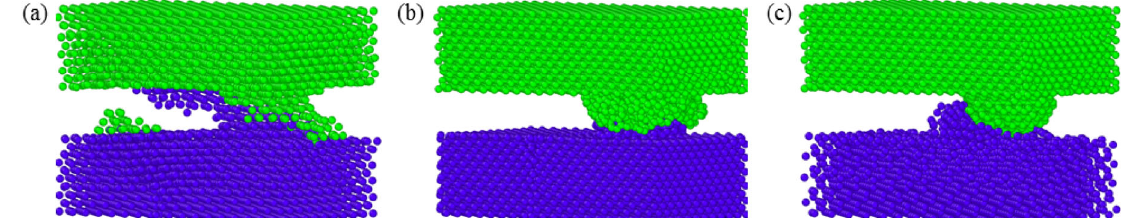
Fig. 3 Single asperity wear situation after the first friction contact for (a) Al–Al fretting interface, (b) diamond–diamond fretting interface, and (c) diamond (upper) –Si (lower) fretting